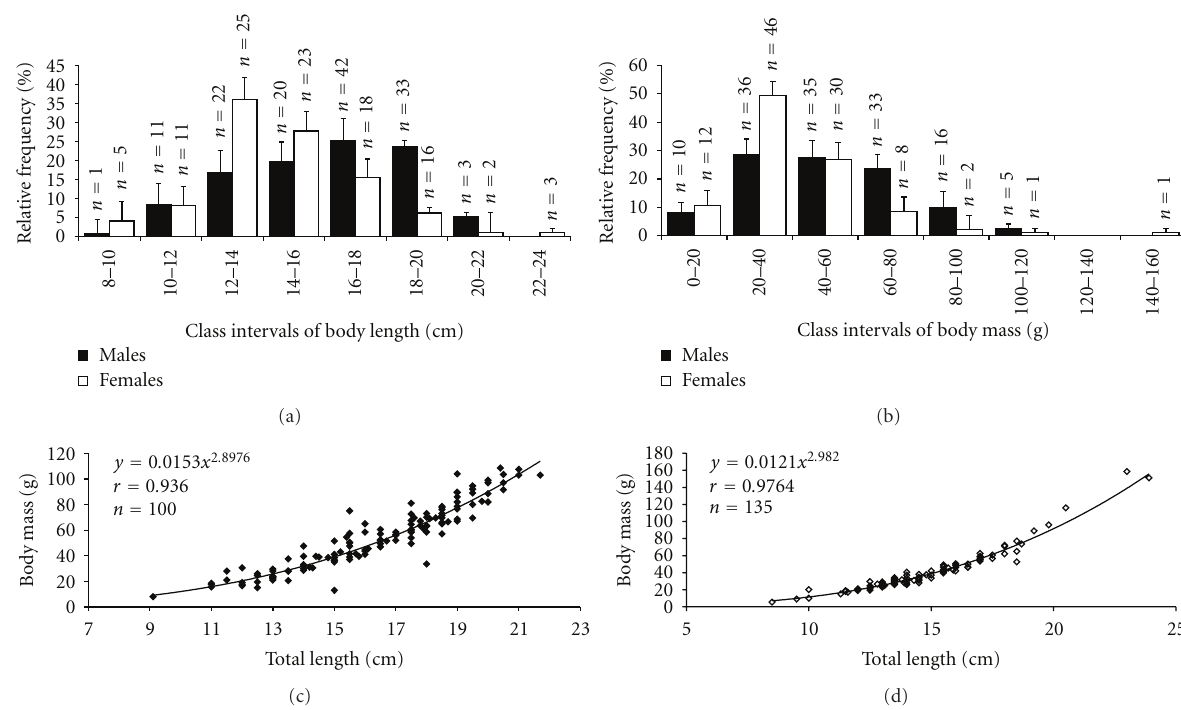
Figure 1: (a) Mean monthly distribution according to class intervals of total body length; (b) mean monthly distribution according to class intervals of body mass; (c) adjusted curve of empirical points of body mass and total body length of females; (d) adjusted curve of empirical points of body mass and total body length of males of C. menezesi